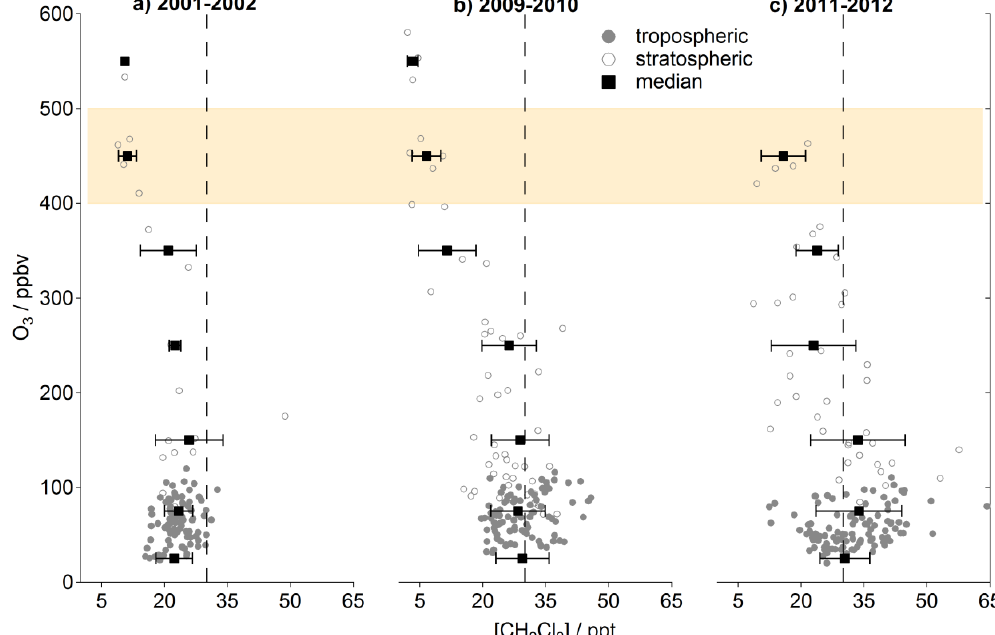
Cl (see Section 1272 2 2 Cl . 1273 2 2